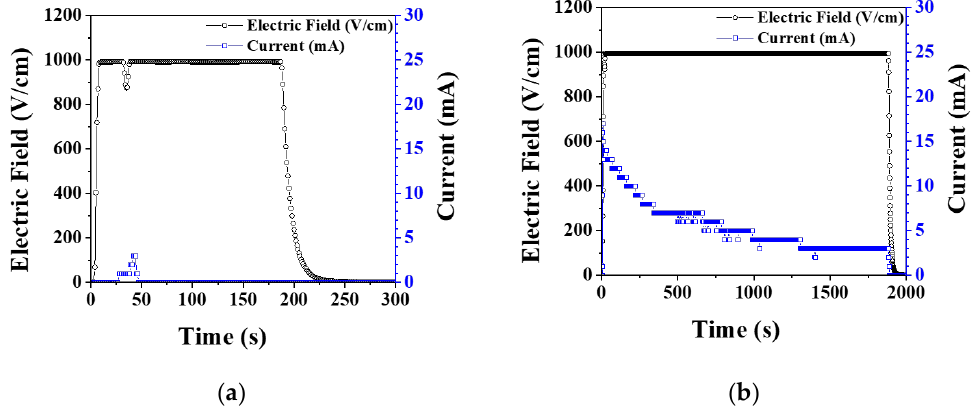
Figure 3. Electric field and current measured during flash sintering of hydroxyapatite under isothermal conditions at 1050 °C and 1000 V ( a ) in air and ( b ) in vacuum.